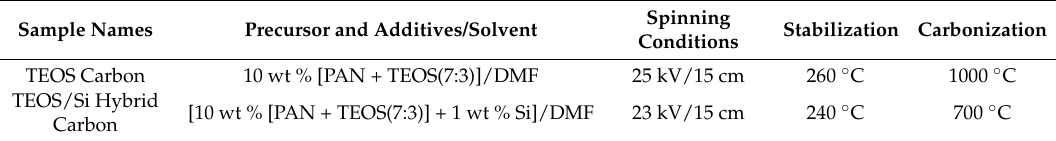
Table 1. Preparation of the carbon nanofibers via